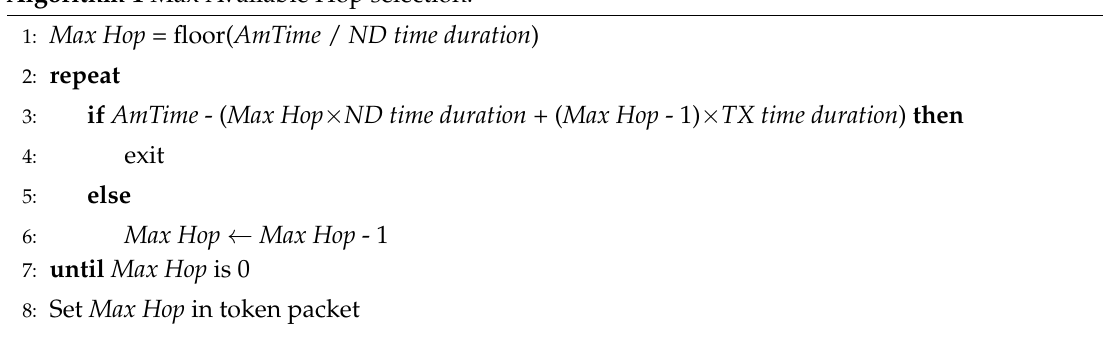
Algorithm 1 Max Available Hop